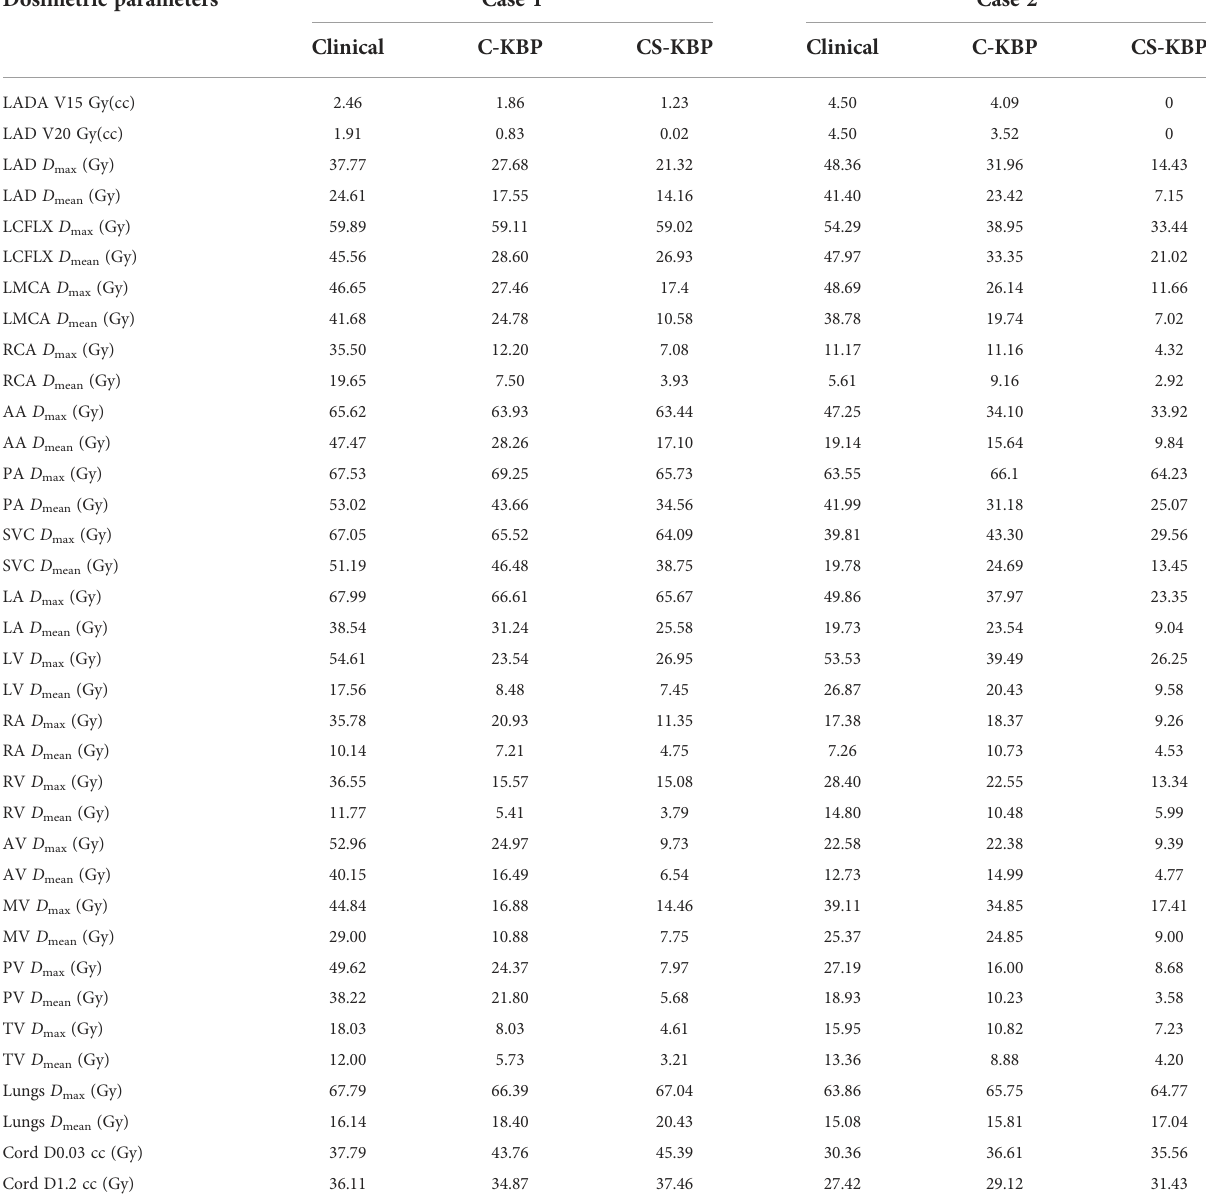
TABLE 2 Comparison of dosimetric parameters among three techniques for two cases shown in Figure 1 . Dosimetric parameters Case 1 Case